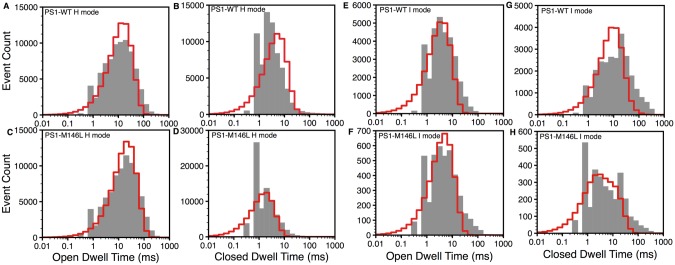
Dwell-time distributions in H and I modes at at 𝓒 = 1μM and 𝓘 = 100nM.Top and bottom rows are for IP3RPS1WT and IP3RPS1M146L respectively. Open (A, C) and closed dwell-time distributions (B, D) in H mode. Open (E, F) and closed dwell-time distributions (G, H) in I mode. Bars are the experimental values and lines are the model fits.